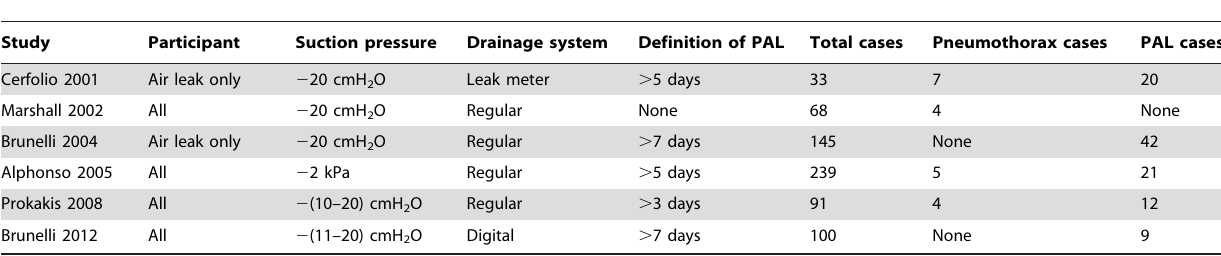
Table 1. Characteristics of Included